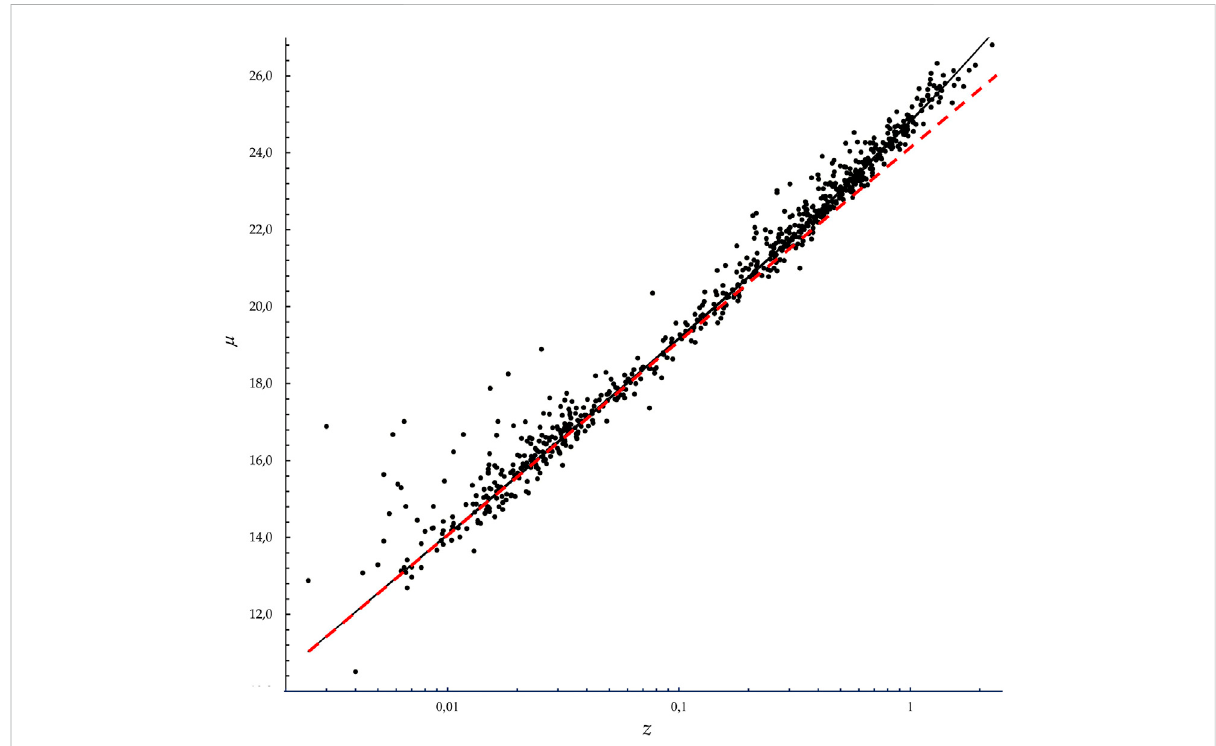
FIGURE 6 Curve calculatedbytheleast-timeprinciple(Eq.27)(solidline)closelyfollows thebrightnessofType Iasupernovaedata,thedistance modulus, μ , vs. redshift, z , rather than the straight line of metric expansion without dark energy (dashed line)